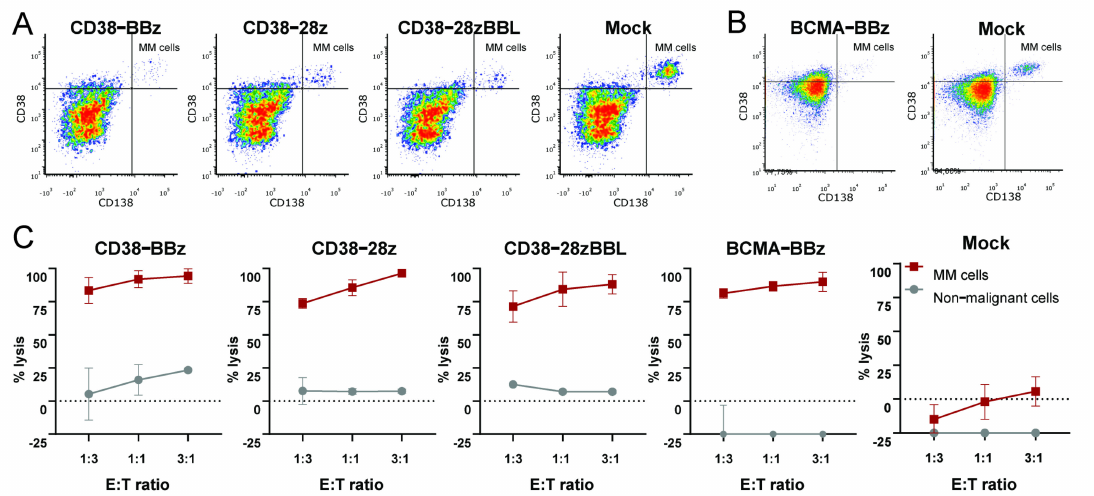
Figure 3. Effective on-tumor and minimal off-tumor cytotoxic activities of CD38 and BCMA CAR-iNKT cells in whole bone marrow samples. Representative flow cytometry density plots of two bone marrow samples depicting the specific eradication of MM cells identified as CD38 + CD138 + cells by CD38-CAR iNKT ( A ) and BCMA-BBz CAR iNKT ( B ) cells in 16 h assays. ( C ) Cytotoxic results of CD38- and BCMA-CAR iNKT cells in various E/T ratios. The error bars indicate the standard error of the mean (SEM )of independent assays with primary bone marrow mononuclear cell (BM-MNC) samples derived from different MM patients (CD38-BBz, CD38-28z, CD38-28zBBL n = 2, BCMA-BBz n = 6, Mock n =